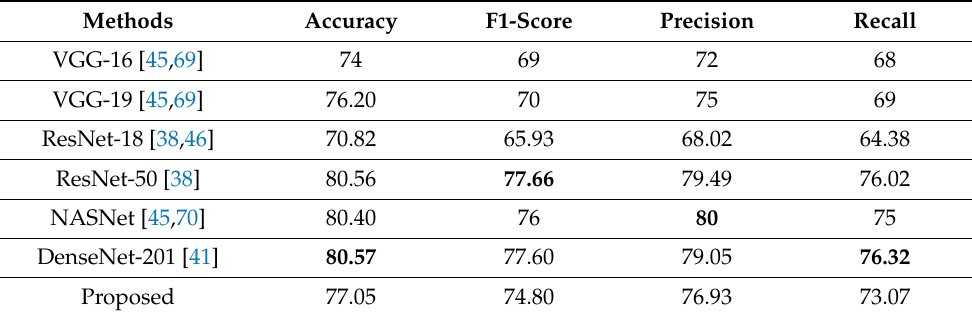
Table 12. Performance comparisons of the state-of-the-art methods and proposed approach with data augmentation by random in-plane rotation and translation. Averages from a 10-fold cross-validation are shown (unit: